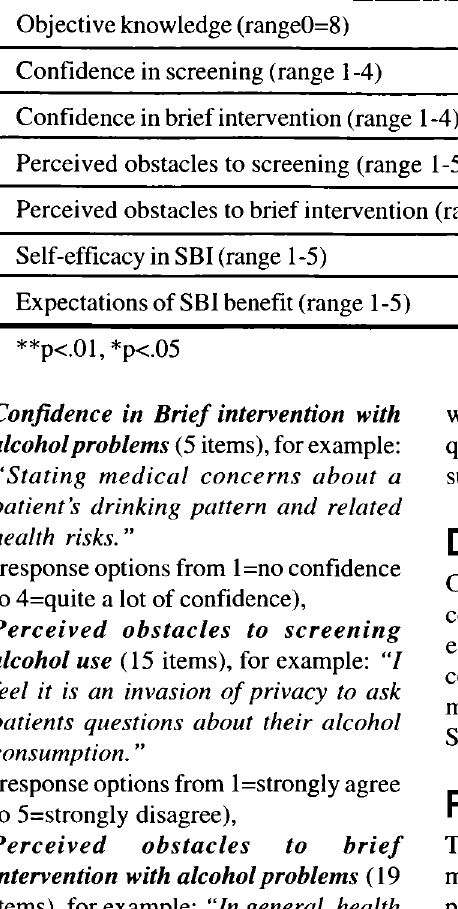
Table 1. Means (standard deviation) of pre- and post training scale scores for knowledge, confidence, perceived obstacles, self-efficacy and expectations/benefits